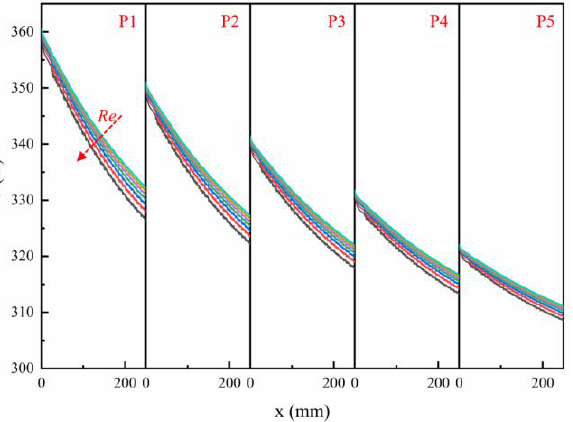
Figure 20. Average static temperature in the stream-wise component for different Reynolds numbers and Prandtl numbers.